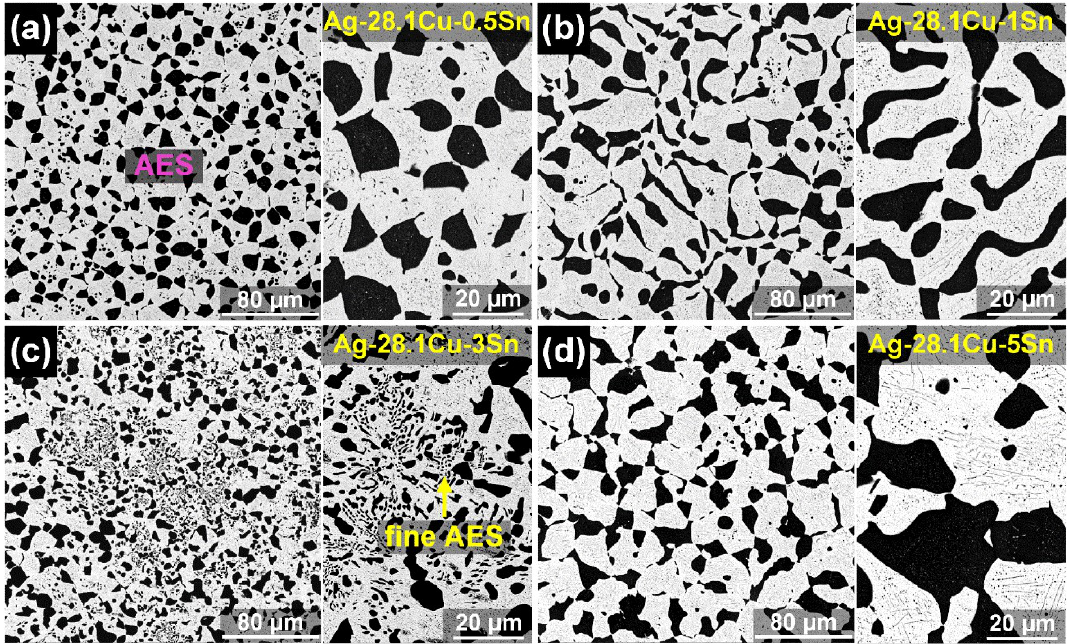
Figure 2. Eutectic morphologies in the Ag-Cu eutectic alloys solidified at 0.1 K/s with different Sn additions: ( a ) Ag-28.1Cu-0.5Sn, ( b ) Ag-28.1Cu-1Sn, ( c ) Ag-28.1Cu-3Sn and ( d ) Ag-28.1Cu-5Sn. Images to the right are magnified images of the Ag-Cu eutectic structures.